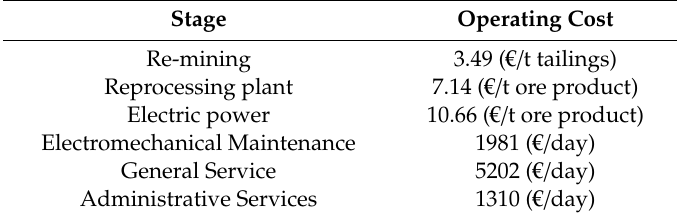
Table 9. Summary of operating cost estimation of the re-mining project of Cabeço do Pi ã o